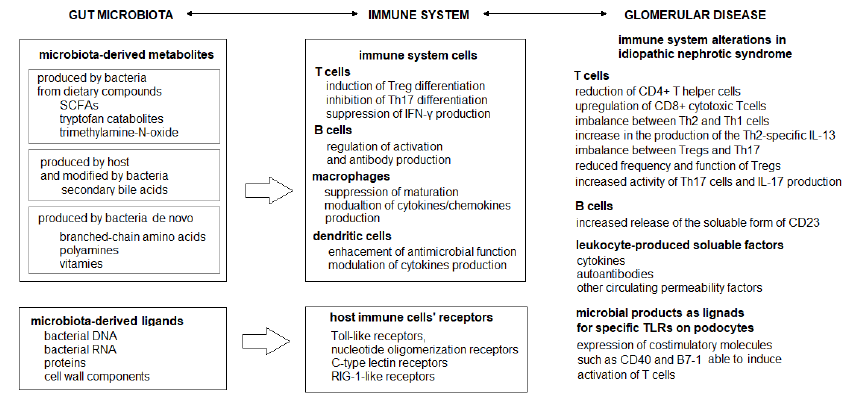
Figure 1. Gut microbiota impact on host immunity and immunological changes observed in idiopathic nephrotic syndrome [15,17,18].